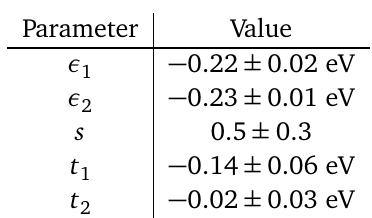
Table 1: Tight binding parameters extracted from Fig.